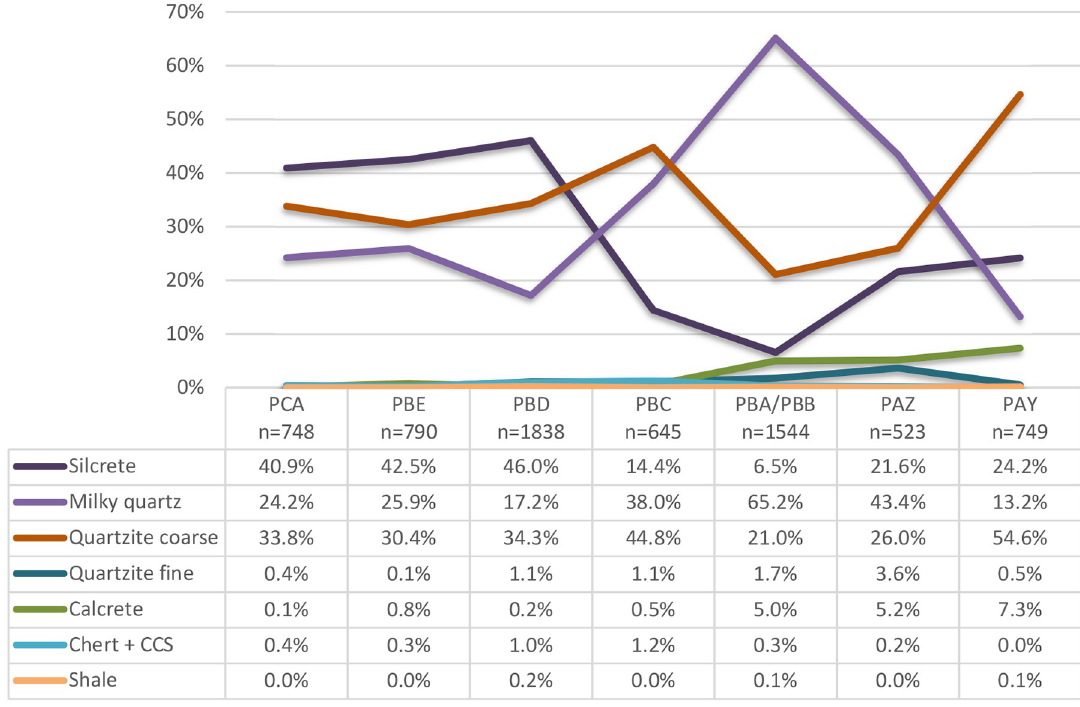
Fig 2. Relative proportions of main raw material types per layer at KDS (lithics � 2cm).